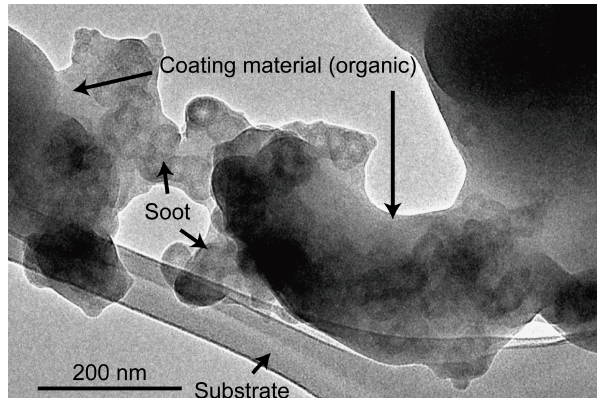
Figure 5. An example transmission electron microscopy (TEM) image of an internally mixed soot particle. The sample was col- lected from biomass burned during the Biomass Burning Observa- tion Project (BBOP) (Adachi et al., 2018). The soot particle has an aggregate structure of spherical monomers and is embedded within organic material. This particle looks similar to the AST-A particles (e.g., no. 6 particle with V r = 5 in Fig. 4).